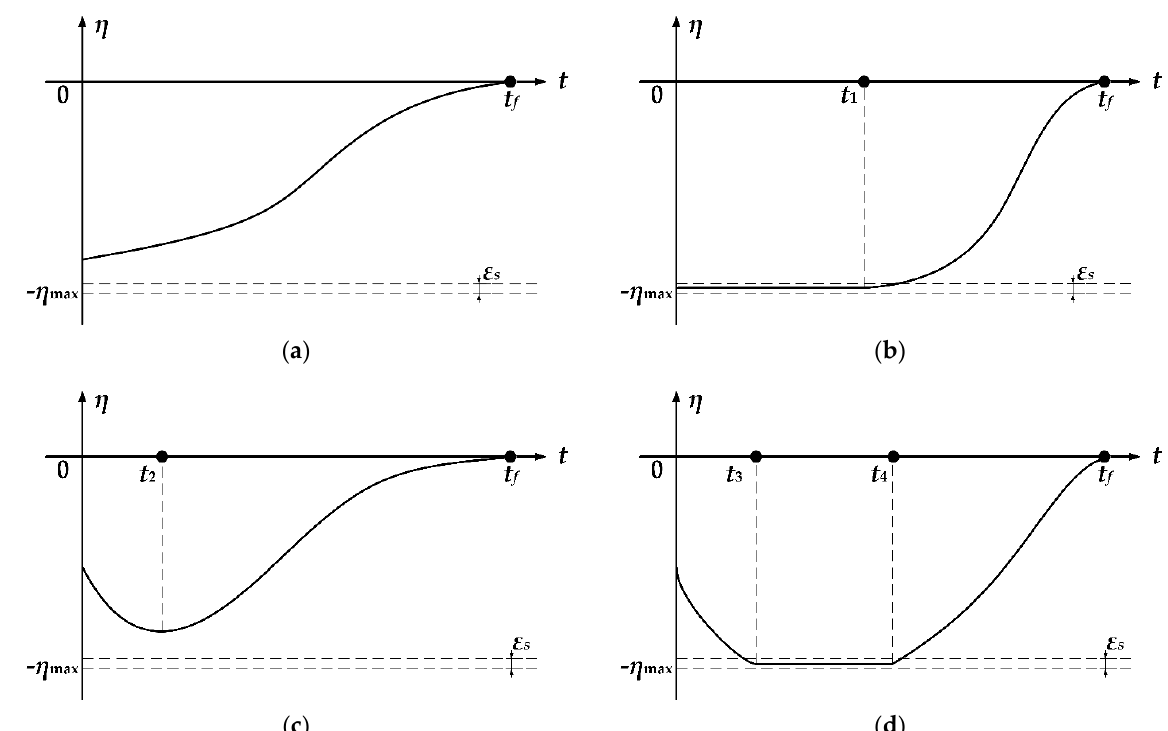
Figure 2. Four cases of lead angle with respect to t : ( a ) Variation of lead angle under case 1; ( b ) Variation of lead angle under case 2; ( c ) Variation of lead angle under case 3; ( d ) Variation of lead angle under case 4.